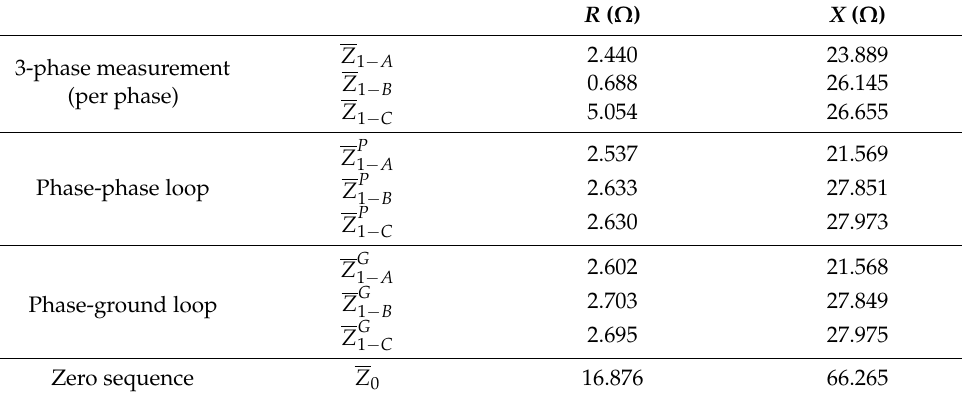
Figure 8. Complete MATLAB Simulink model for determination of positive and zero sequence impedance by simulation (example of 3-phase symmetrical measurement of positive sequence impedance). Table 3. Simulation results of symmetrical components (per phase).